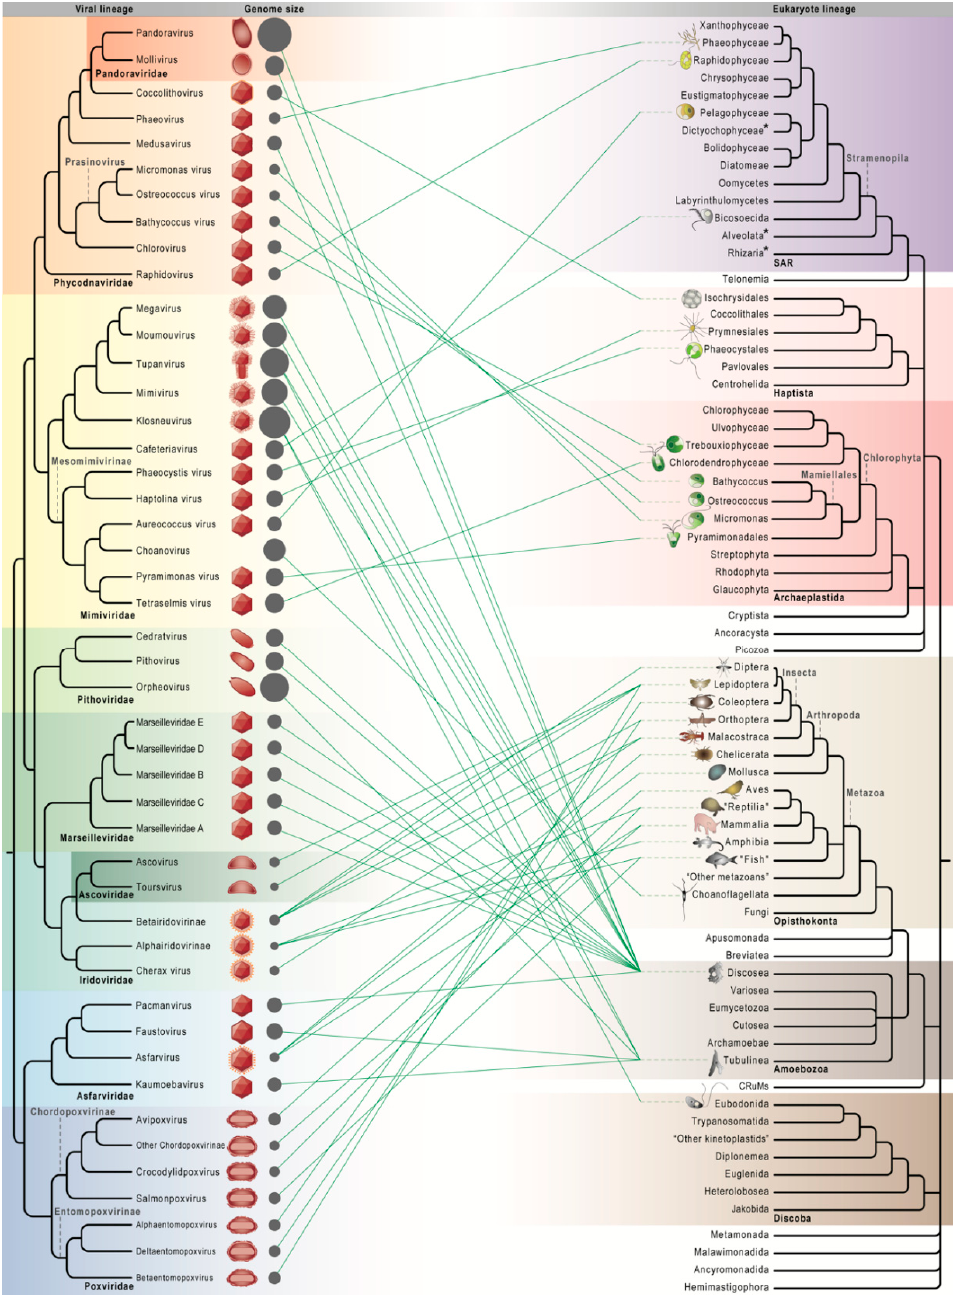
Figure 1. Cophylogenetic relationships between giant viruses and eukaryotes. Virus-host connections are mapped onto reference trees summarizing giant virus phylogenies based on up to 10 putatively vertically inherited core genes [13,14,37,42,43] and phylogenetic relationships across the eukaryotic tree of life [27,44–50]. The seven commonly delineated giant virus clades (seven families with two nested families) are divided into subfamilial lineages, each of which comprises one or more viral strains with known hosts (Table S1), with a schematic diagram of virion morphology, if known, and the average genome size across strains (proportional to the circle area; Table S1) shown. Names in double quotes correspond to non-monophyletic groupings. * Giant viruses are also known to infect the SAR lineages dictyochophytes (Stramenopila) [51,52], dinoflagellates (Alveolata) [53], and chlorarachniophytes (Rhizaria) [52], but their phylogenetic positions in the virus reference tree are less certain.